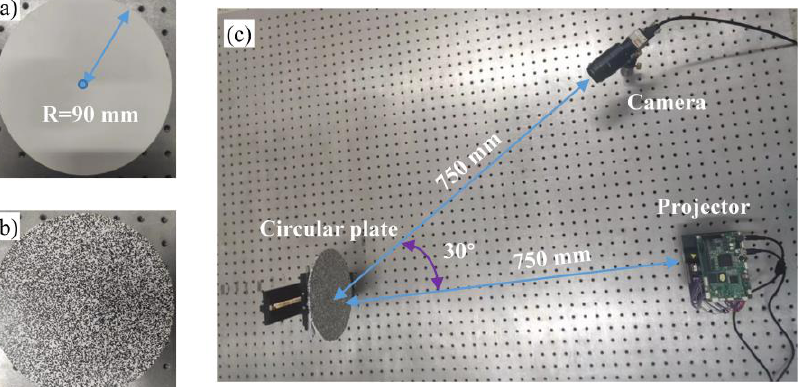
Figure 4. The experimental setup. ( a ) Circular plate without speckles; ( b ) circular plate with speckles; ( c ) the experimental setup.